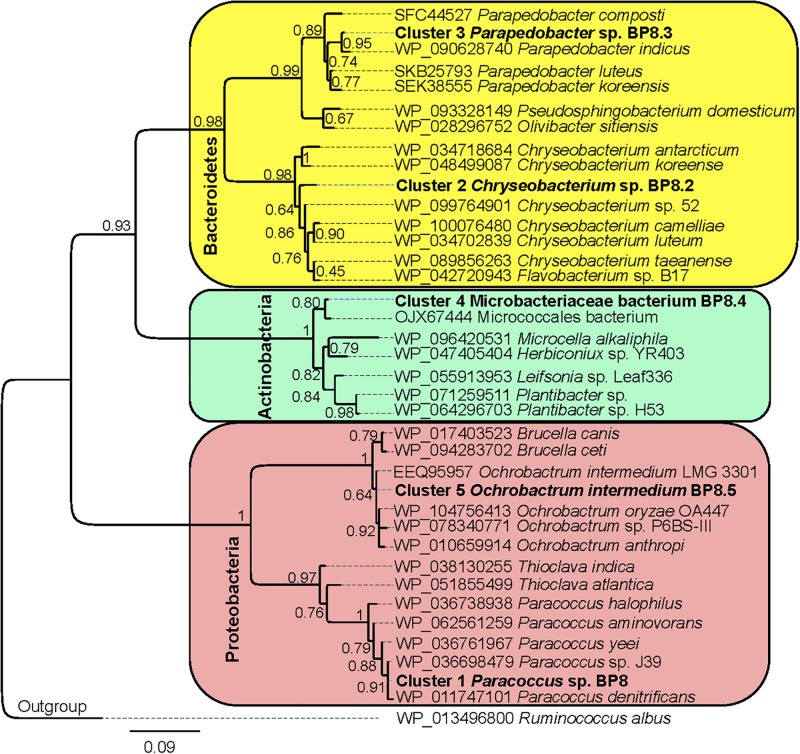
Maximum likelihood phylogeny for taxonomic delimitation of the deconvoluted genomes from the BP8 metagenome. The analysis was performed with three phylogenetic markers: ribosomal protein L3, ribosomal protein S5 and DNA gyrase A subunit, which generated similar results. The analysis for ribosomal protein L3 is presented. Branch support values are indicated in the corresponding nodes. Bar indicates the number of expected substitutions per site under the WAG + G model. A sequence of Ruminococcus albus (Firmicutes) was used as outgroup. Key genome clusters are highlighted in bold and different Phyla are indicated at the left. Sequences for L3 ribosomal proteins of the deconvoluted genomes are accessible in the NCBI GenBank under accession numbers RQP07704.1, RQP15098.1, RQP16503.1, RQP08603.1, and RQP16393.1 for clusters 1–5, respectively.